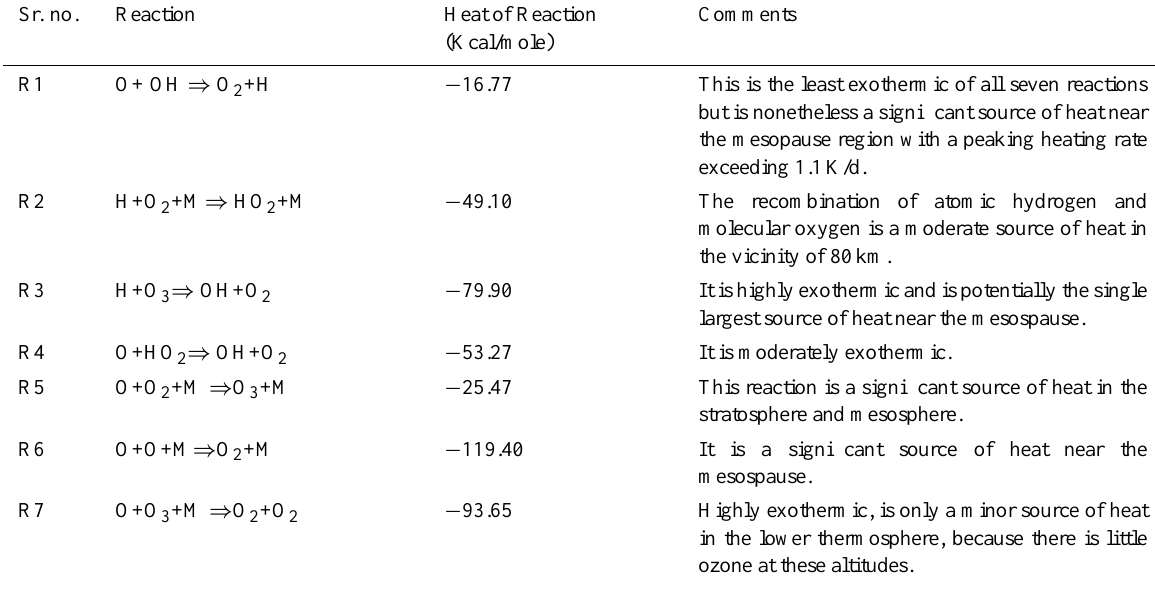
Table 1. Exothermic reactions responsible for significant heating in the middle atmosphere. Sr. no. Reaction Heat of Reaction Comments (Kcal/mole) − 16.77 This is the least exothermic of all seven reactions but is nonetheless a significant source of heat near the mesopause region with a peaking heating rate exceeding 1.1K/d. − 49.10 The recombination of atomic hydrogen and molecular oxygen is a moderate source of heat in the vicinity of 80km. − 79.90 It is highly exothermic and is potentially the single largest source of heat near the mesospause. It is moderately exothermic. − 25.47 This reaction is a significant source of heat in the stratosphere and mesosphere. It is a significant source of heat near the mesospause. − 93.65 Highly exothermic, is only a minor source of heat in the lower thermosphere, because there is little ozone at these